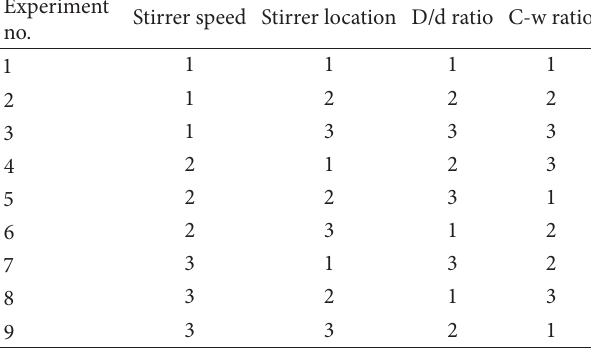
Table 4: 𝐿 9 (3 4 ) standard orthogonal